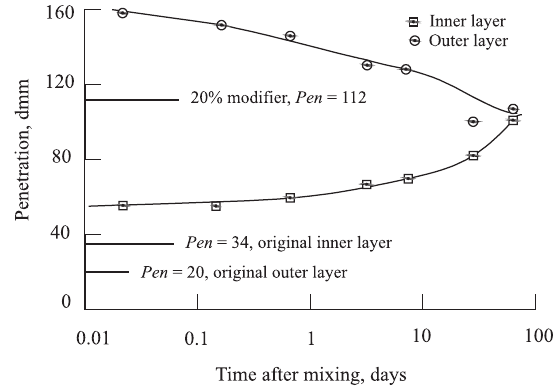
Fig. 4. Penetration of the outer and inner layers as a function of time (by Carpenter, Wolosick